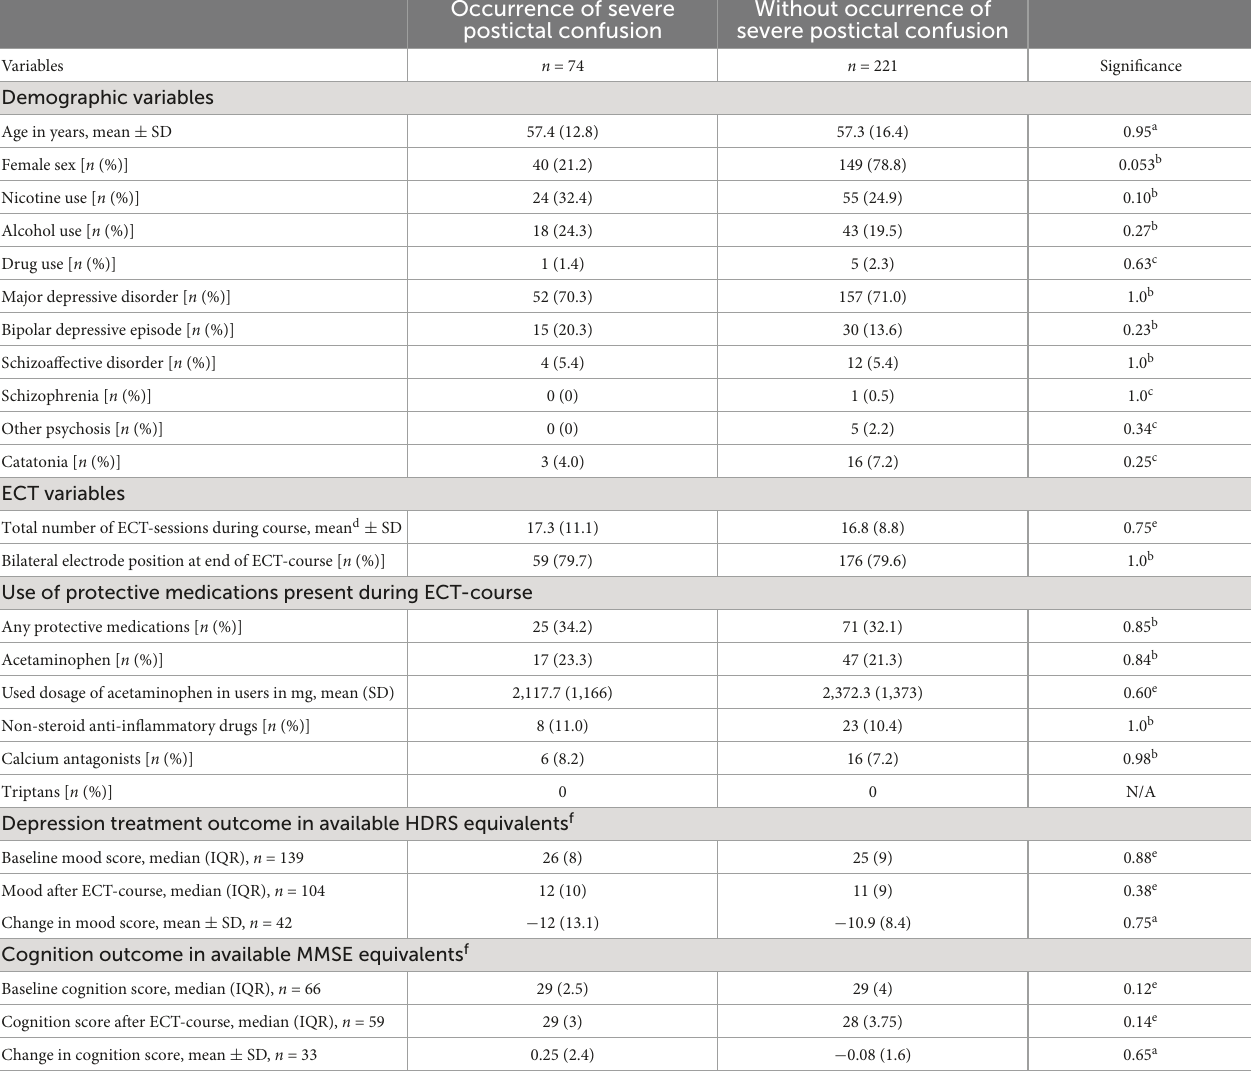
TABLE 2 Univariate statistics of patient-, treatment-, and outcome characteristics in 295 patients treated with electroconvulsive therapy (ECT), in whom severe postictal confusion occurred directly after any ECT-session ( n = 74) and in those without sPIC ( n = 221). Occurrence of severe Without occurrence of postictal confusion severe postictal